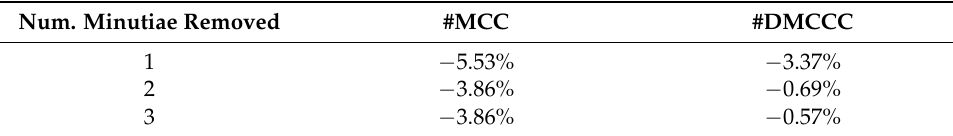
Table 1. Percentages in which there was a rank drop taking into account only those minutiae labeled with the class “higher.”